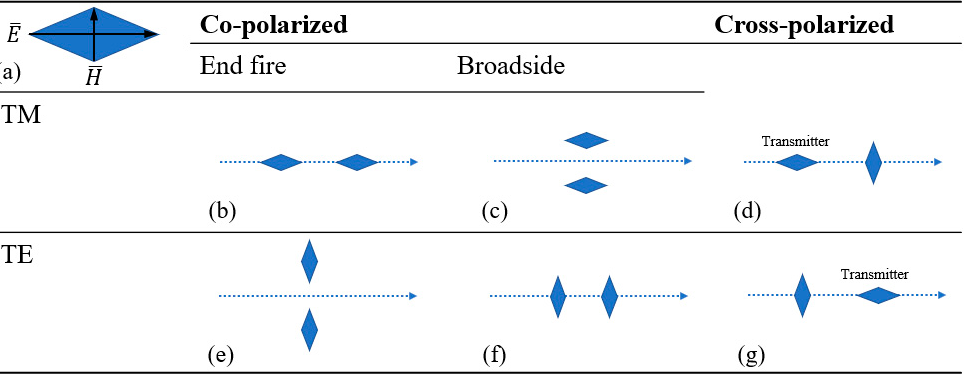
Figure 5. Plan view of the different possible transmitter-receiver configurations. ( a ) Directions of electric vector and magnetic vector in an antenna; ( b ) End fire TM mode; ( c ) Broadside TM mode; ( d ) Cross-polarized TM mode; ( e ) End fire TE mode; ( f ) Broadside TE mode; ( g ) Cross-polarized TE mode.